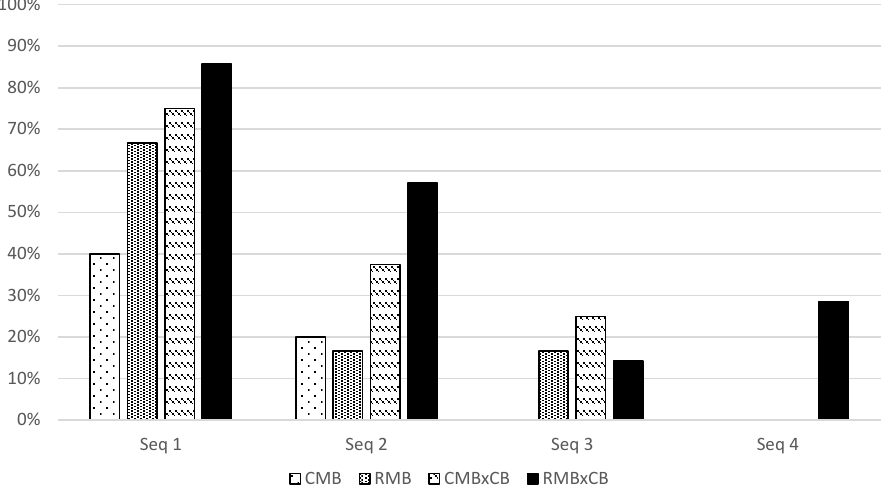
Figure 2. Percentage of Completed Group Projects by Sequence.